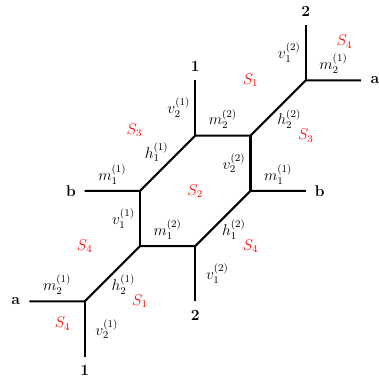
Figure 12 . Toric web diagram and parametrisation of X (1)